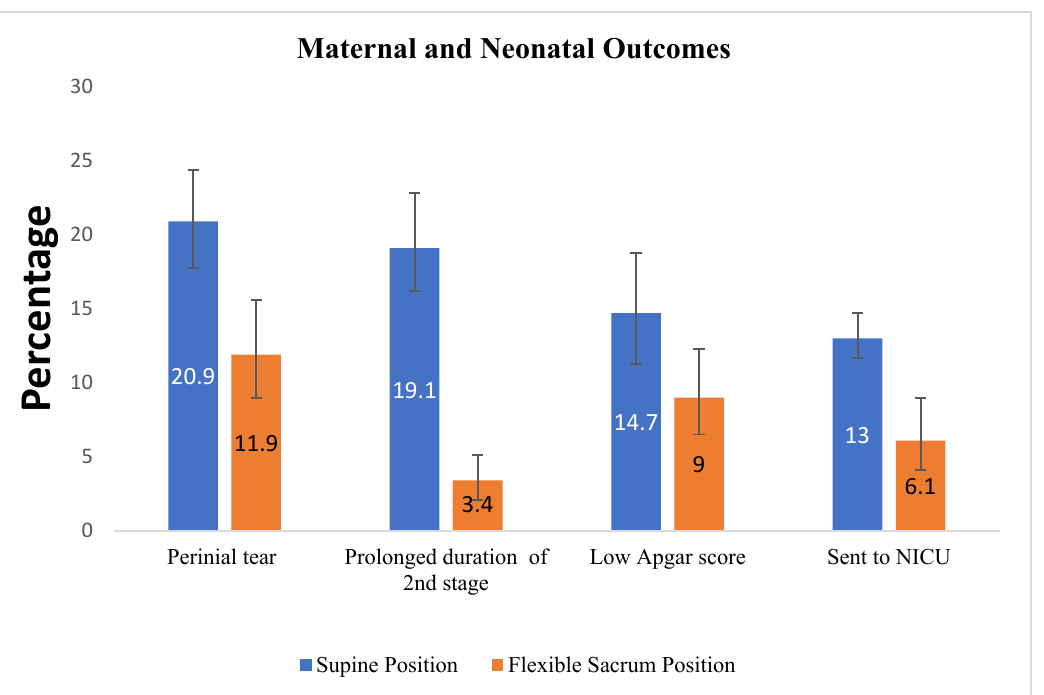
Figure 4. Percentage of maternal and neonatal outcomes compared in the intervention and control group in Amhara public Health facilities, 2019. The percentage was first calculated with 100%, for categories of outcomes, then the result was compared between the intervention and control groups. Perineal tear was for the “Yes” response.